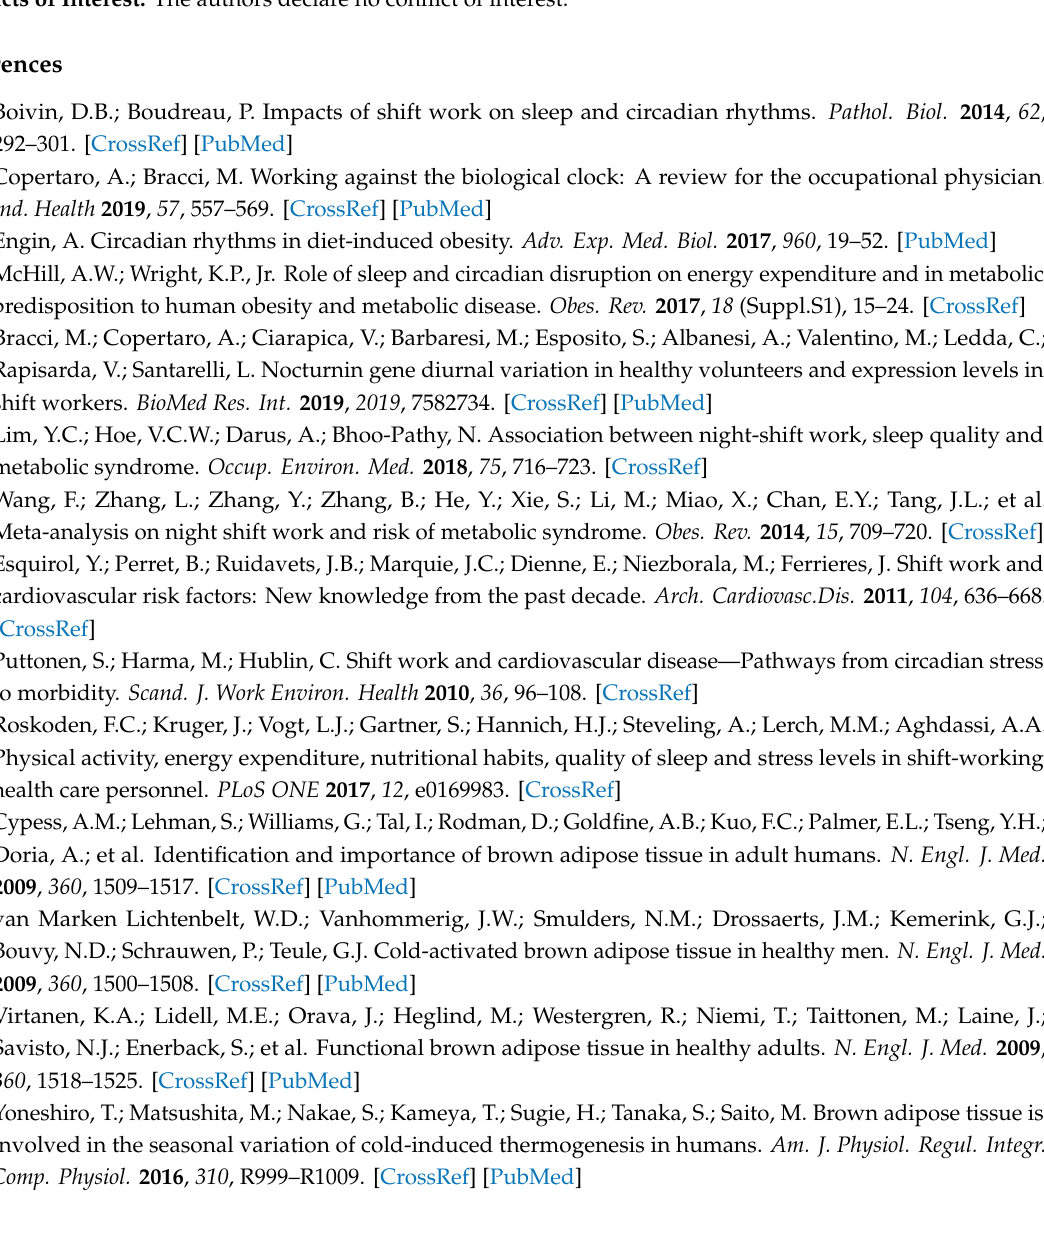
Table S1: miRNA-target interaction network for miR-92a. The central node is the miR-92a, surrounded by validated targets with strong evidence (green), weak evidence (blue), and predicted targets (yellow). Targets are listed below the